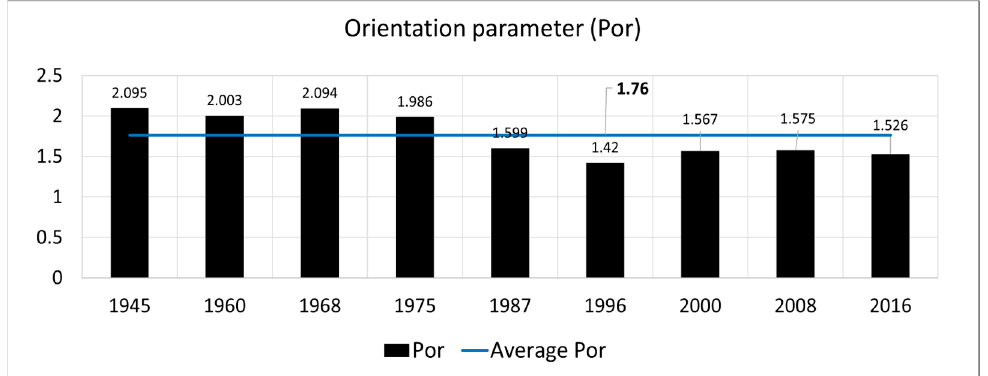
Figure 4. Kotychi Lagoon restriction ratio (Pr) index fluctuations during the study period. The blue line represents the average Pr value.